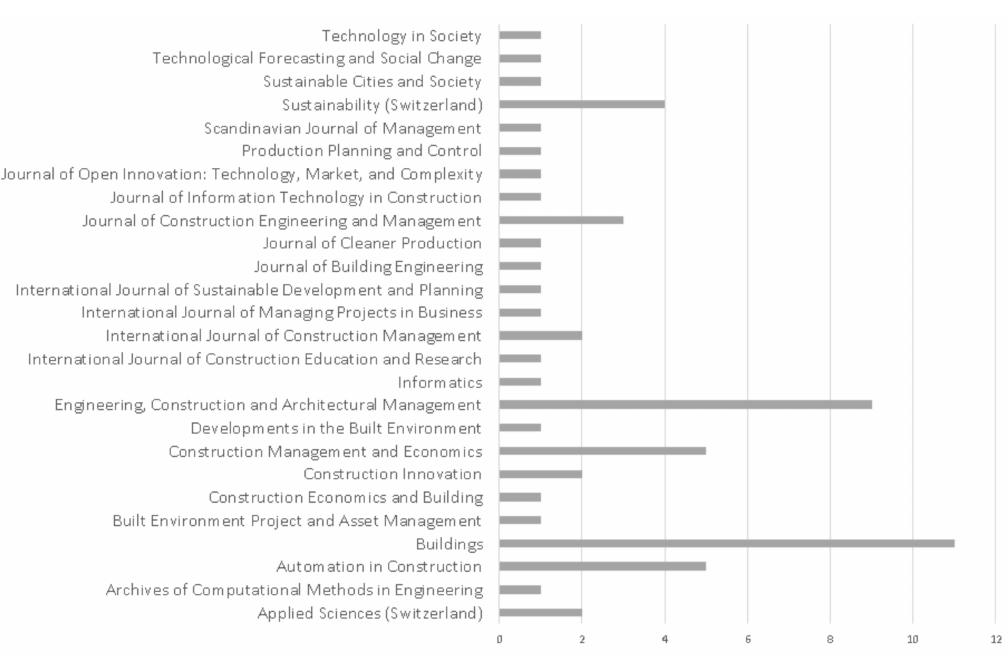
Figure 4. Journal distribution against article